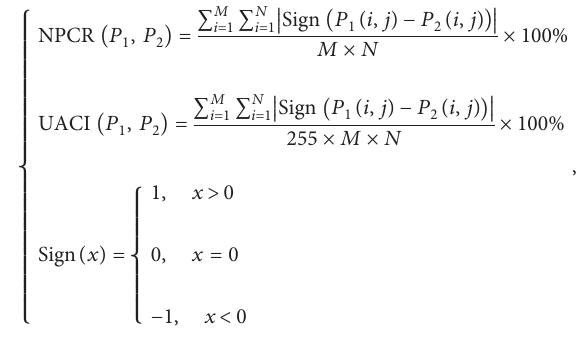
Figure 9: Sensitivity analysis. (a) The decrypted image when x image when z of Lorenz map changes from 0 to 0